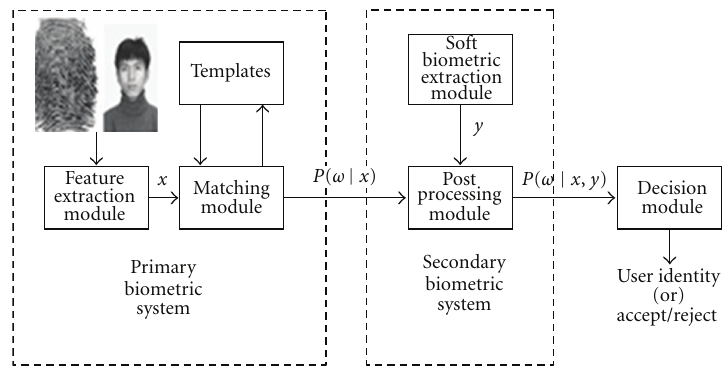
Figure 2: Integration of soft biometric traits with a biometric system.